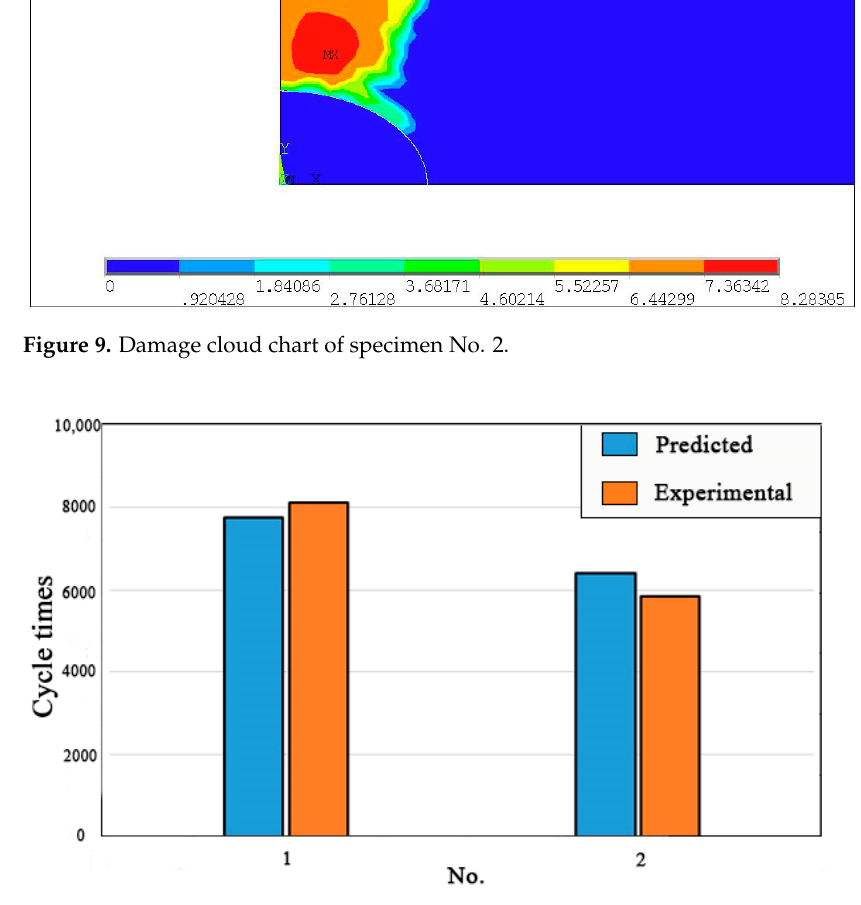
Figure 10. Experimental life vs. Predicted life.